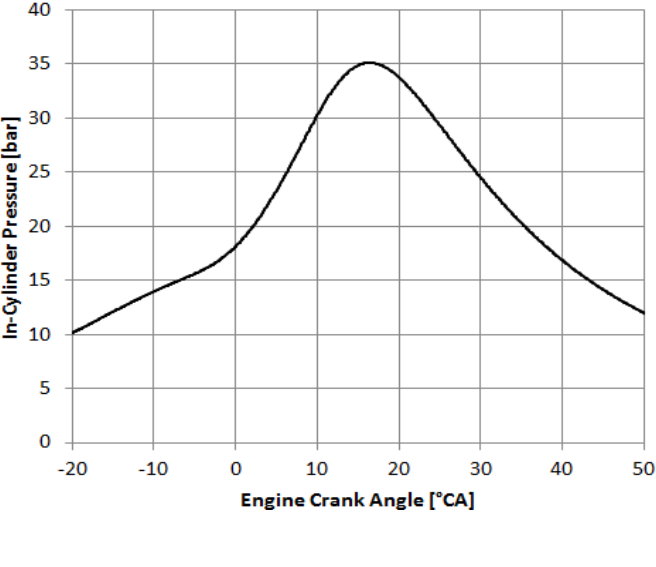
Figure 8. Pressure trace for a single engine